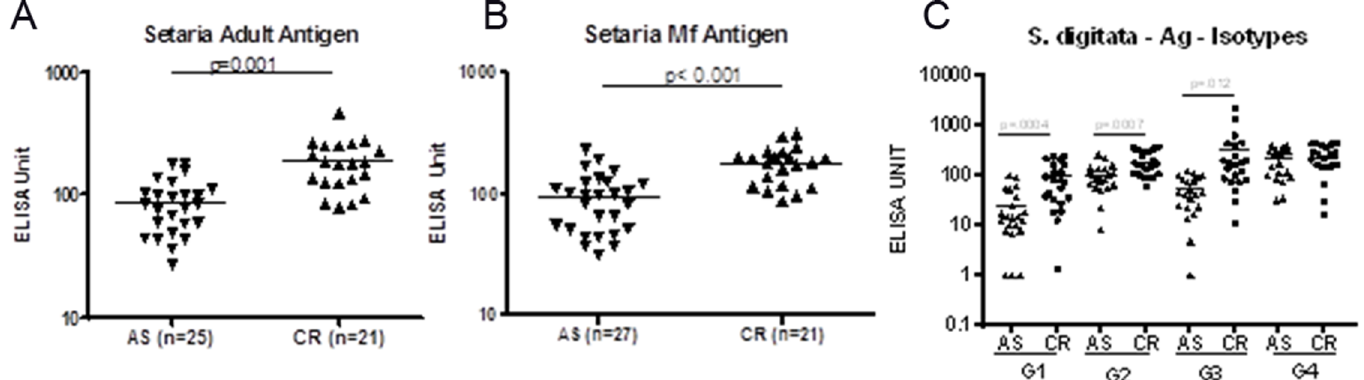
Fig 2. Profile of IgG and IgG subclasses against different filarial antigens. Plasma levels of IgG and IgG subclasses were analyzed by ELISA. IgG against whole somatic antigen of adult Setaria worm (A) and Setaria MF (B) were analyzed. IgG isotypes against somatic antigen of adult setaria worm were analysed (C). Mean of 30 and 31 samples were